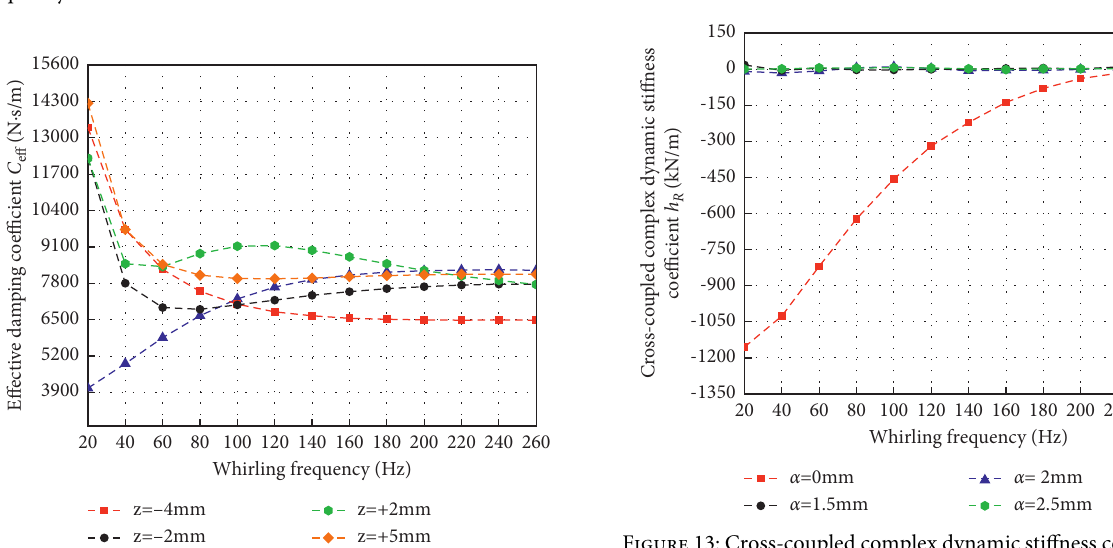
Figure 10: Average direct damping coefficient vs. whirling frequency.